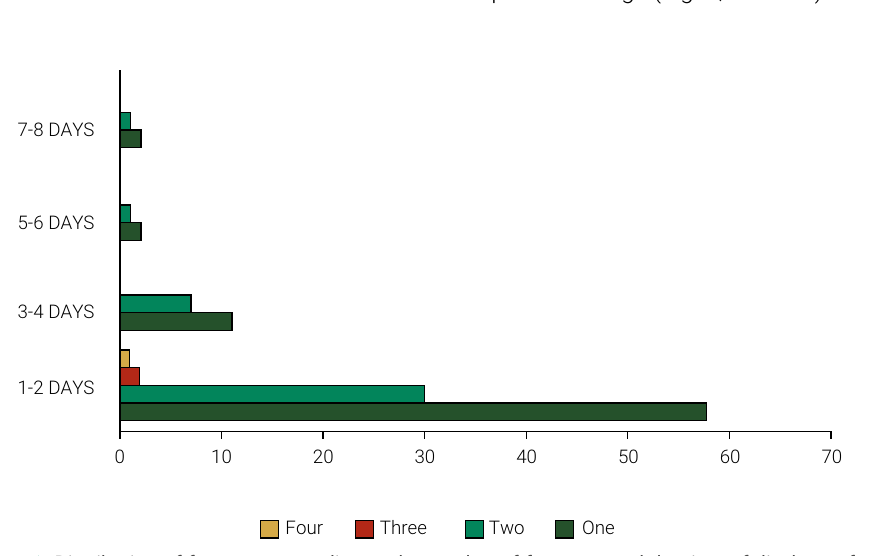
Figure 1. Distribution of fractures according to the number of fractures and the time of discharge from hospital (P > 0.05, according to the Pearson’s chi-squared